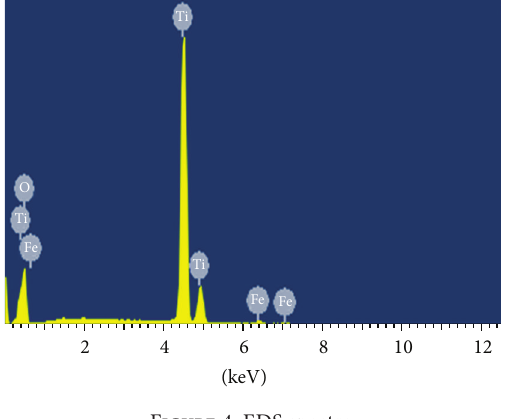
Figure 4: EDS spectra.